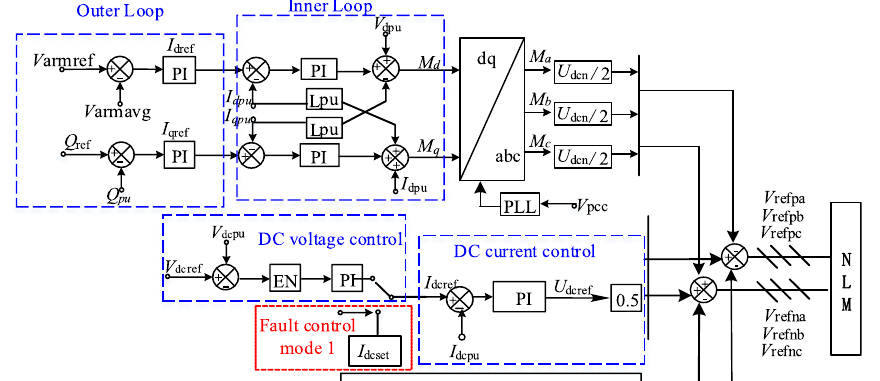
Fig. 4 Control block diagram of hybrid MMC